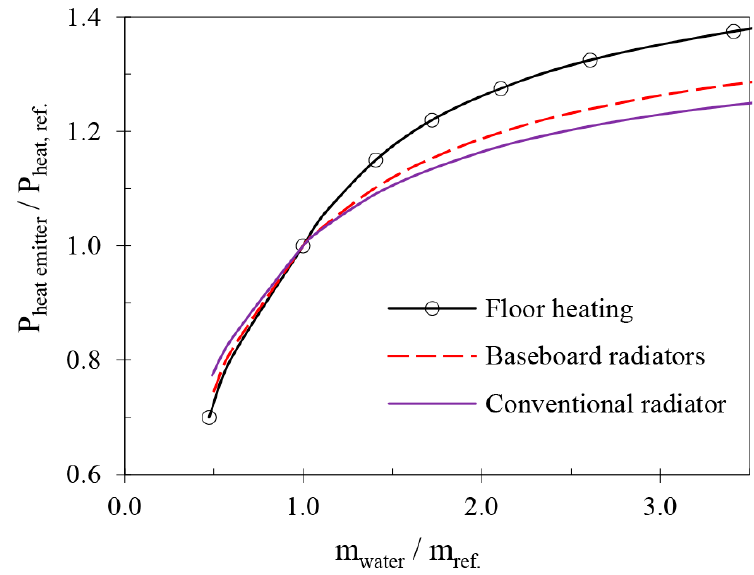
Figure 7. The variation of relative heat output with change in relative water flow rate for floor, baseboard and conventional radiator heating systems. The water flows are normalized by m water, ref. = 0.01 kg/s, and the heat outputs by corresponding output, P heat, ref. , at 0.01 kg/s.